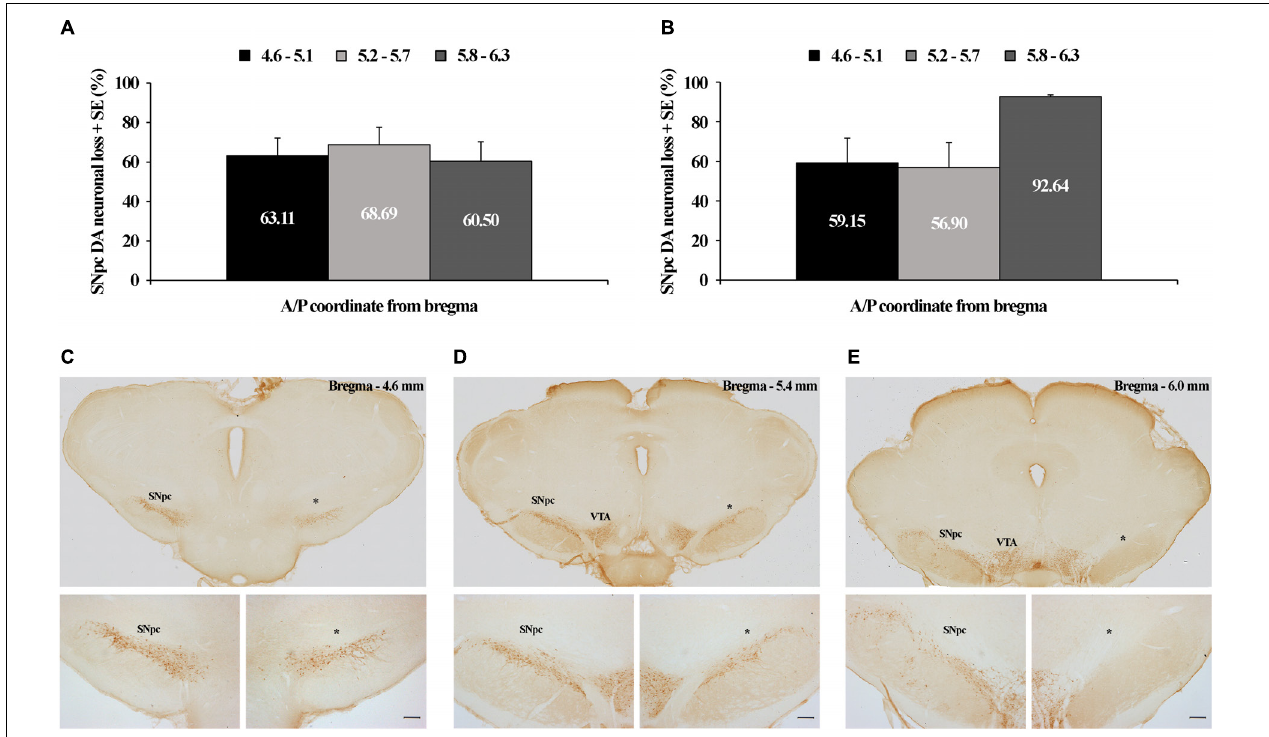
FIGURE 1 | Tyrosine hydroxilase (TH) immunohistochemical identification and quantification of the unilateral substantia nigra pars compacta (SNpc) dopaminergic neuronal loss. Quantified dopaminergic neuronal loss in the unilateral SNpc lesion caused by the microinfusion of 12 µ g/1 µ l 6-OHDA (A) and 12 µ g/2 µ l 6-OHDA (B) . Individual example of three sections used for the quantification of each SNpc lesioned brain (C–E) , representing three defined stereotaxic ranges with an identified SNpc partial lesion, caused by 12 µ g/1 µ l 6-OHDA, throughout the overall rostro-caudal SNpc dimension. The dopaminergic neuronal loss in this SNpc was: 62.30% from 4.6 to 5.1 mm caudally from bregma; 74.47% from 5.2 to 5.7 mm caudally from bregma; and 93.34% from 5.8 to 6.3 mm caudally from bregma. VTA, ventral tegmental area; ∗ – indicates the lesioned SNpc; Scale bar 200 µ m. The scale bars of the upper (C–E) panels, representing only the typical brain sections for the specific SNpc stereotaxic range, are not defined, since they were obtained by the acquisition of the images by using the 10 × objective lens of the Olympus BX-51 microscope, equipped with a motorized stage and CCD video camera (Pixelink, Ottawa, ON, Canada), and by using a superimage acquisition option within the newCAST stereological software package (VIS-Visiopharm Integrator System, version 5.3.1.1640; Visiopharm; Denmark).